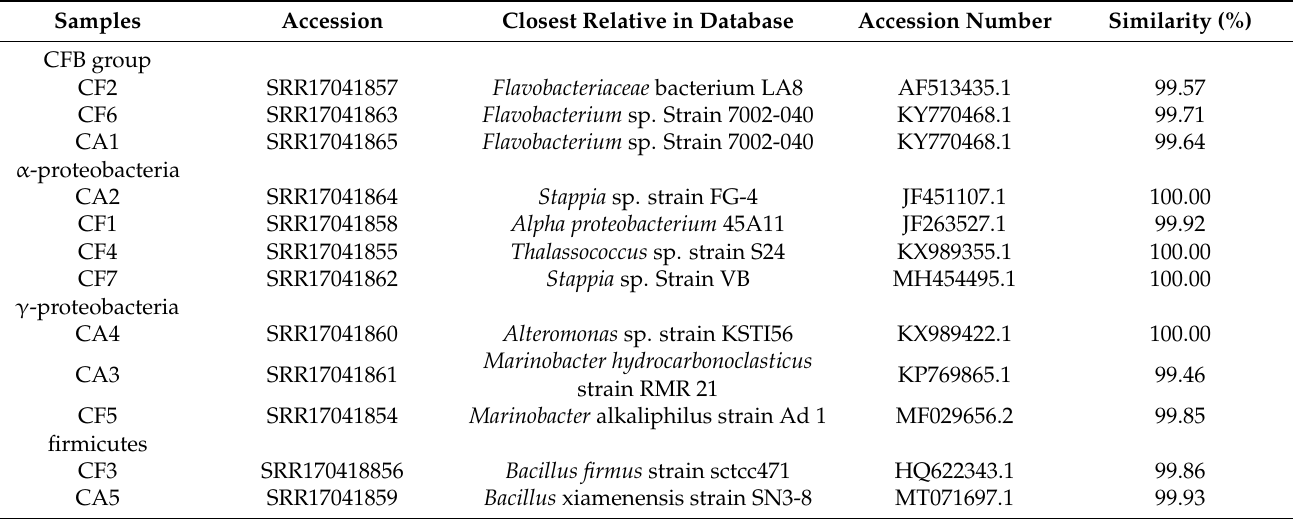
Table 1. Identification of 12 strains of phycosphere